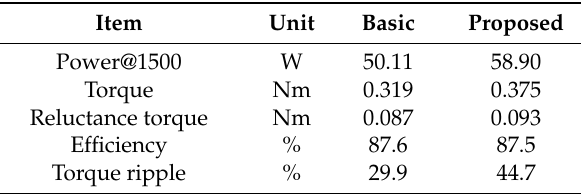
Figure 8. Calculated saturation curves.